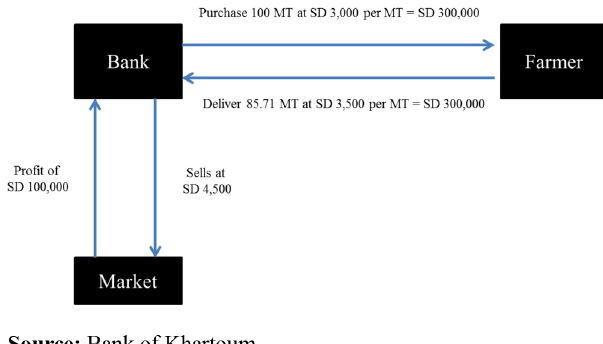
Figure 2. Case 1 – price of